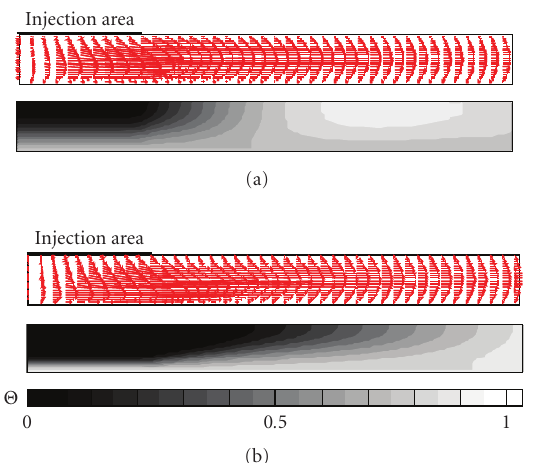
Figure 3: Velocity and temperature distributions in stationary disk at h/D i = 0 . 05, (a) Re = 360, (b) Re = 2000.